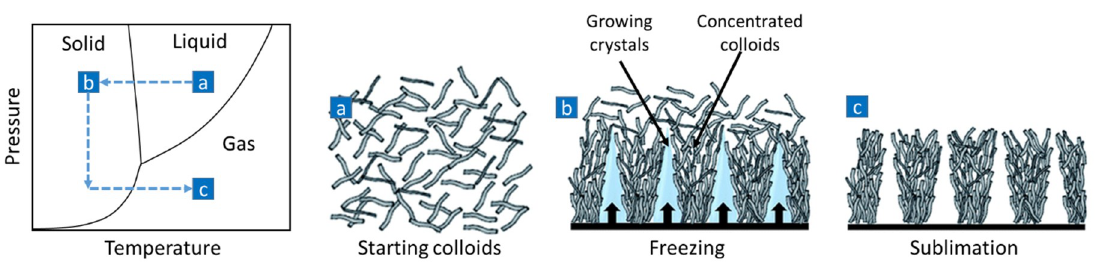
Figure 3. Scheme of the principle of ice‐templating. (Adapted from Lavoine and Bergström [52] with permission from the Royal Society of permission from the Royal Society of Chemistry).